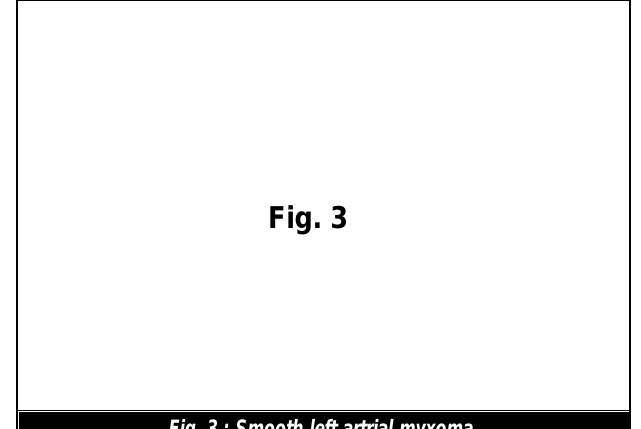
Fig. 3 : Smooth left artrial